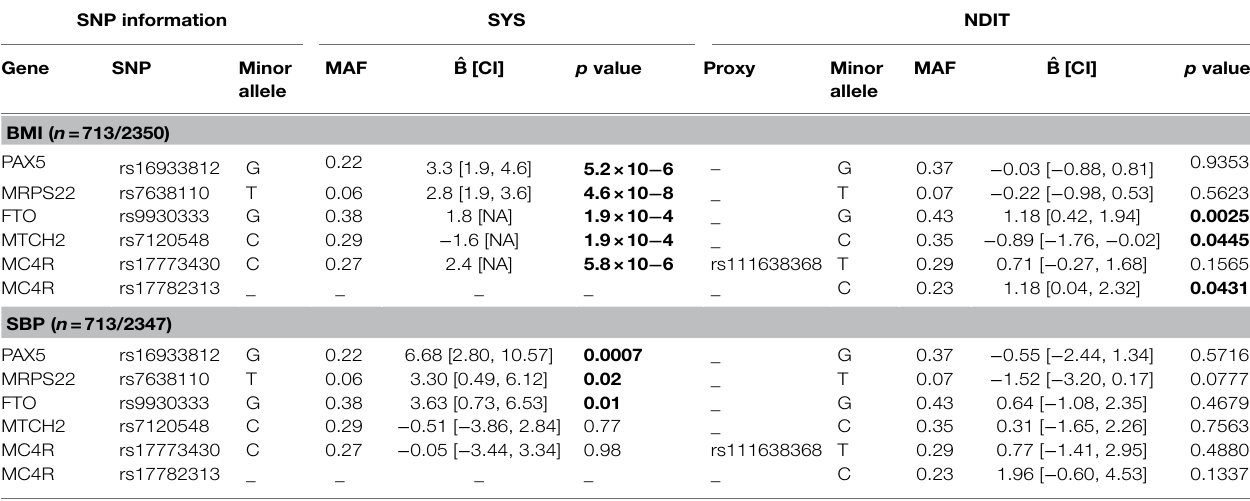
TABLE 3 | Estimated coefficients of the investigated SNPs in their association with BMI and SBP, NDIT 1999–2012 and Melka et al. (2012) 2003–2009**. SNP information SYS